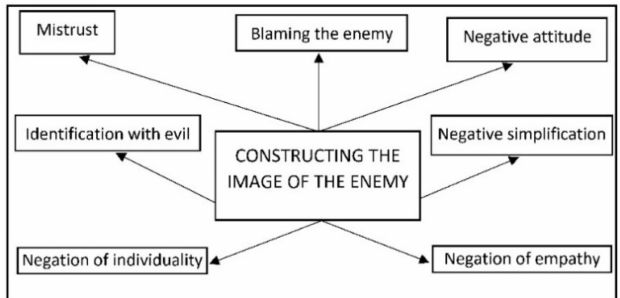
Figure 1. Constructing the image of the enemy